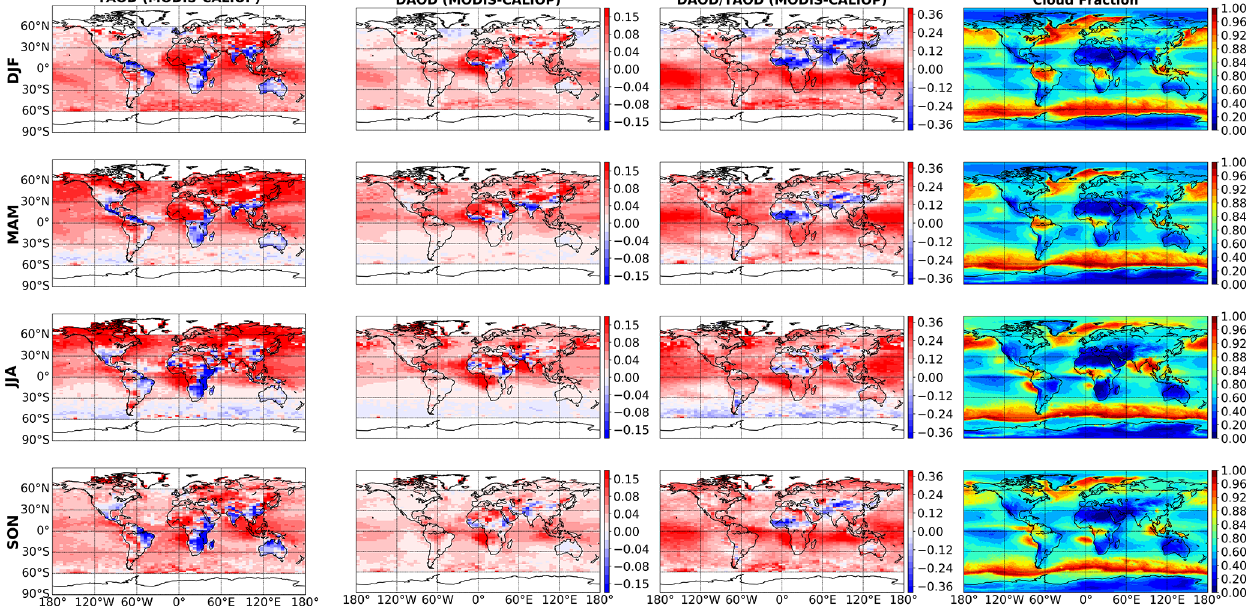
Figure 7. The difference between MODIS and CALIOP for seasonal mean TAOD (the first column), DAOD (the second column), and the fraction of DAOD in TAOD (the third column) on a basis of the 13-year (2007–2019) average. The fourth column is the seasonal mean cloud fraction from MODIS L3